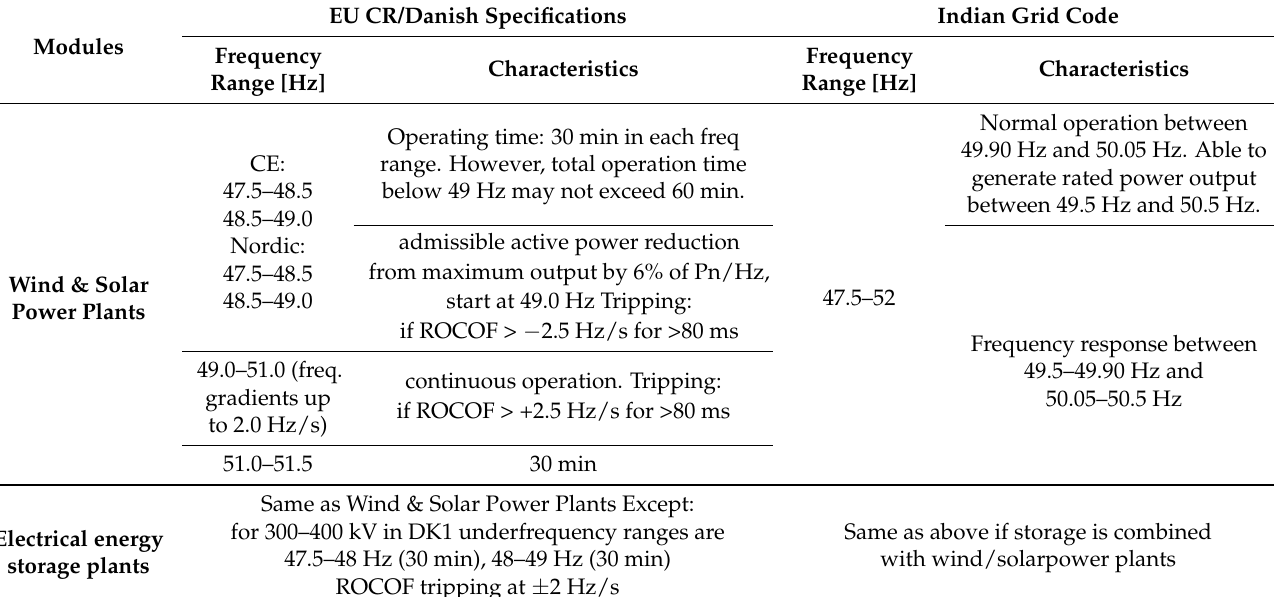
Table 2. Operational frequency range in Denmark and